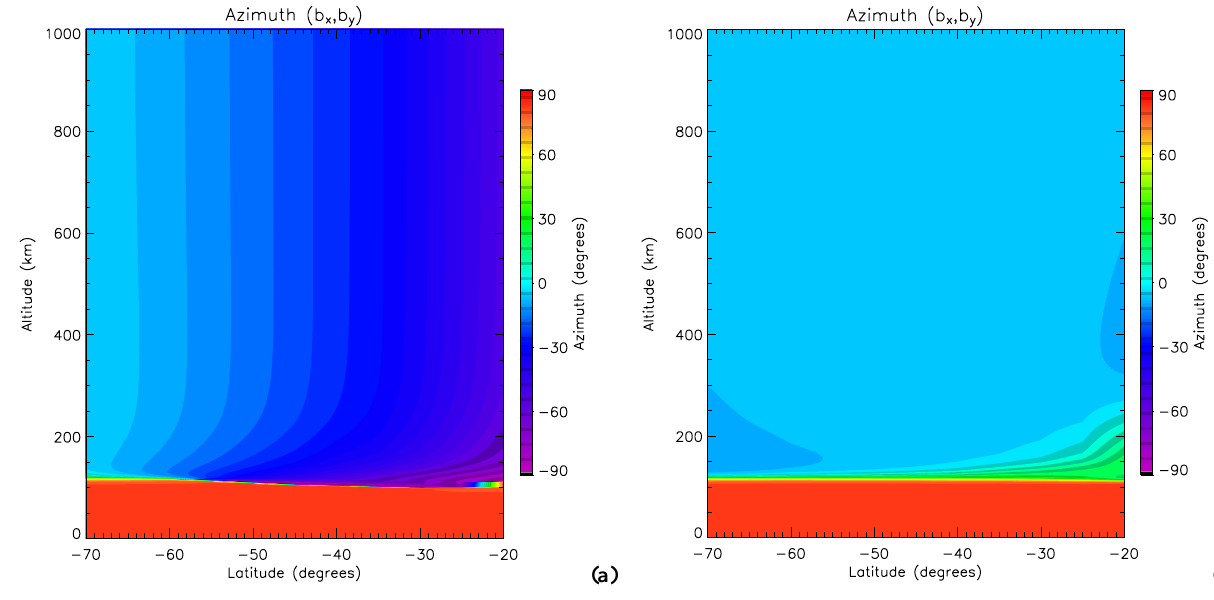
Fig. 6. ULF wave polarisation azimuth computed from the b x and b y components for a frequency of 25mHz. The IRI-95 model parameters were chosen for conditions on 28 September 2000 for the 160 ◦ geographic longitude at 10:00 LT. The geographic latitudes vary between 70 ◦ and 20 ◦ south. The north-south wavenumber is k x = 10 − 10 m − 1 . The azimuthal wavenumber, (a) m =3, (b) m